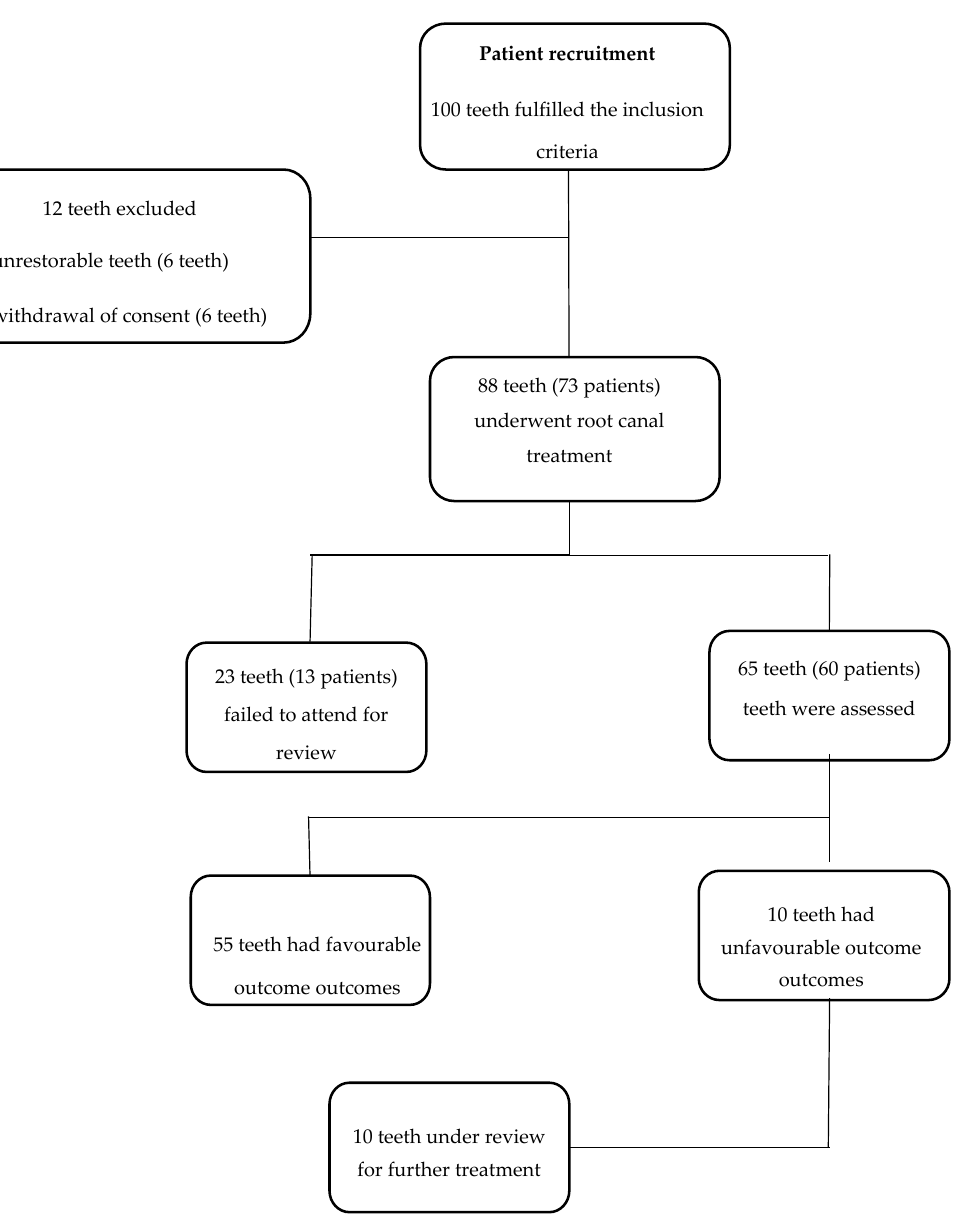
Figure 1. Flowchart of the trial showing the process of patient recruitment, exclusion and follow-up .